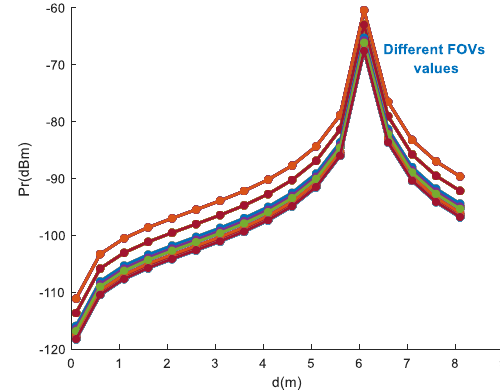
Fig. . Power received vs. distance for different FOVs